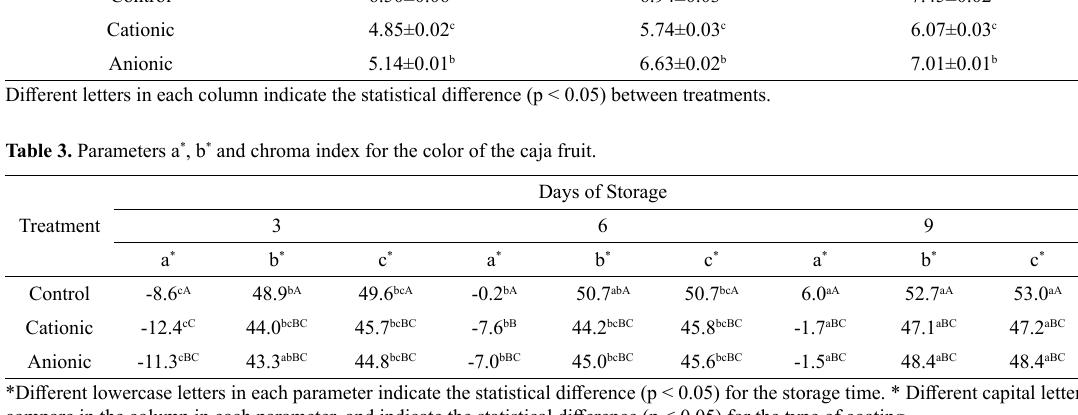
CAT: Clay with cationic treatment; ANI: Clay with anionic treatment. Different letters in each column indicate the statistical difference (p < 0.05) between treatments. Table 2. Mass loss (%) of the caja fruit. Treatment